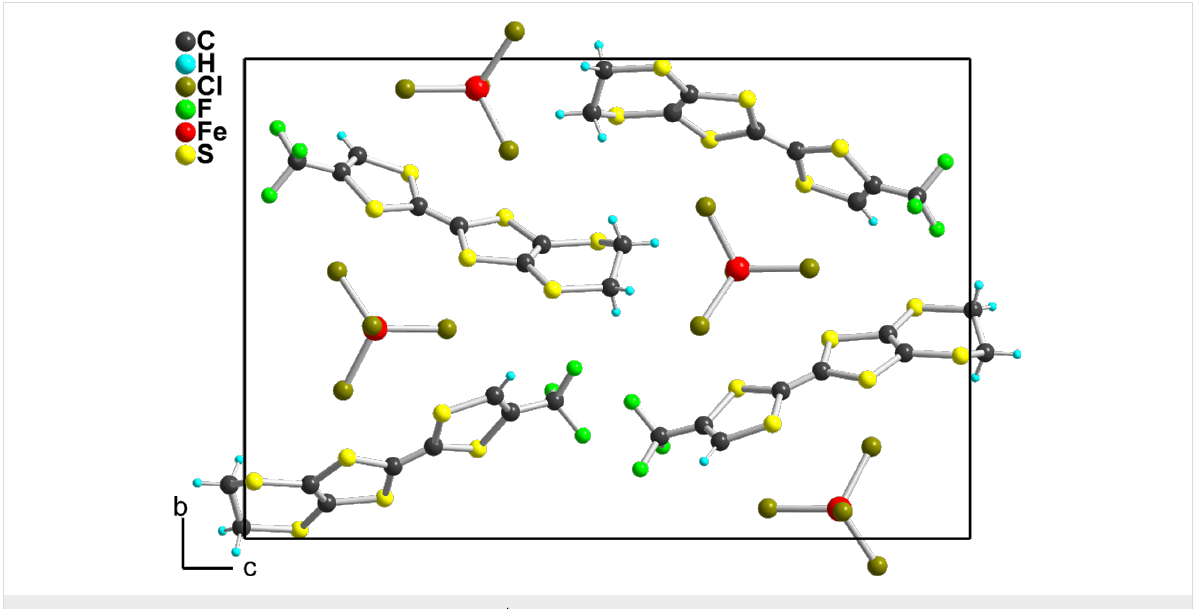
Figure 9: Projection view along the a axis of the unit cell of ( 1c +• )(FeCl 4 −